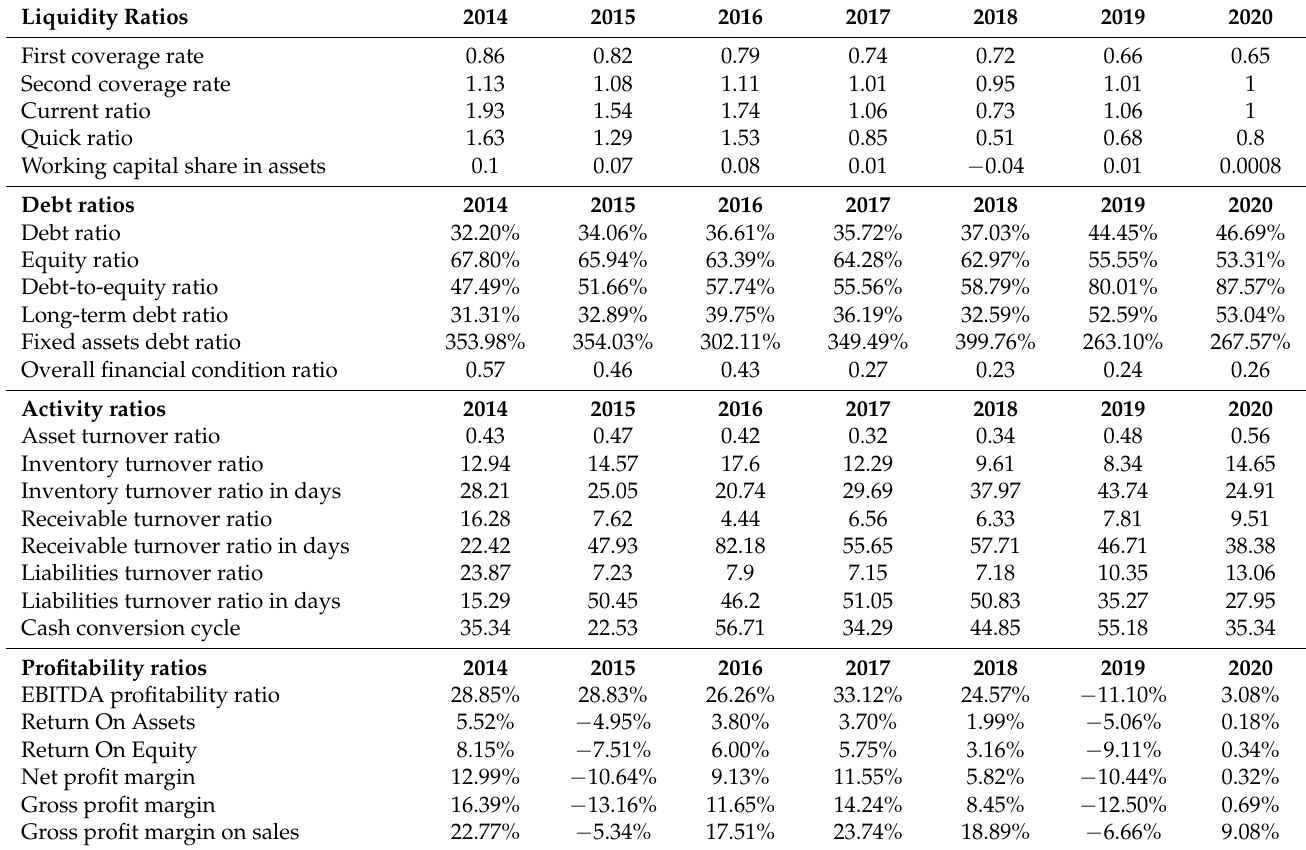
Table 4. Financial ratios of the PGE Capital Group in